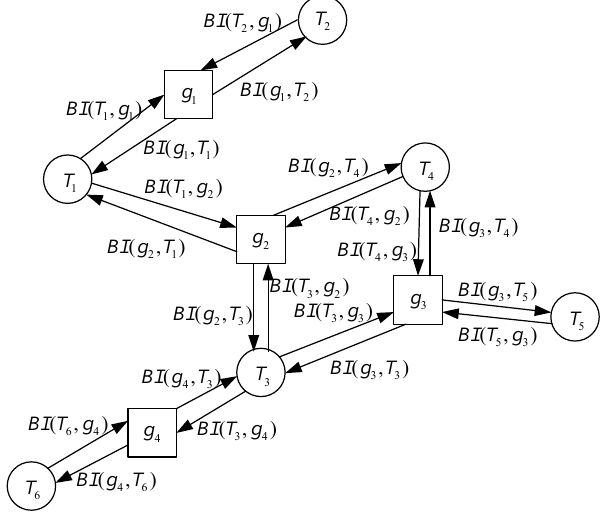
Figure 1. The structure of factor-graph-assisted distributed cooperative